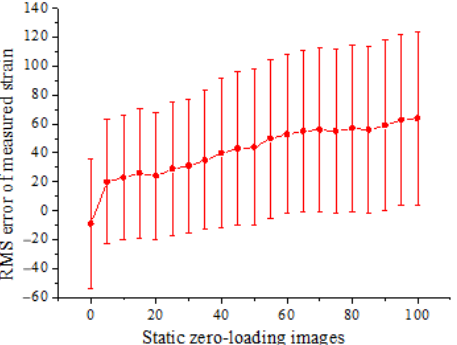
Figure 18. RMS error of strain computed from the static undeformed column.